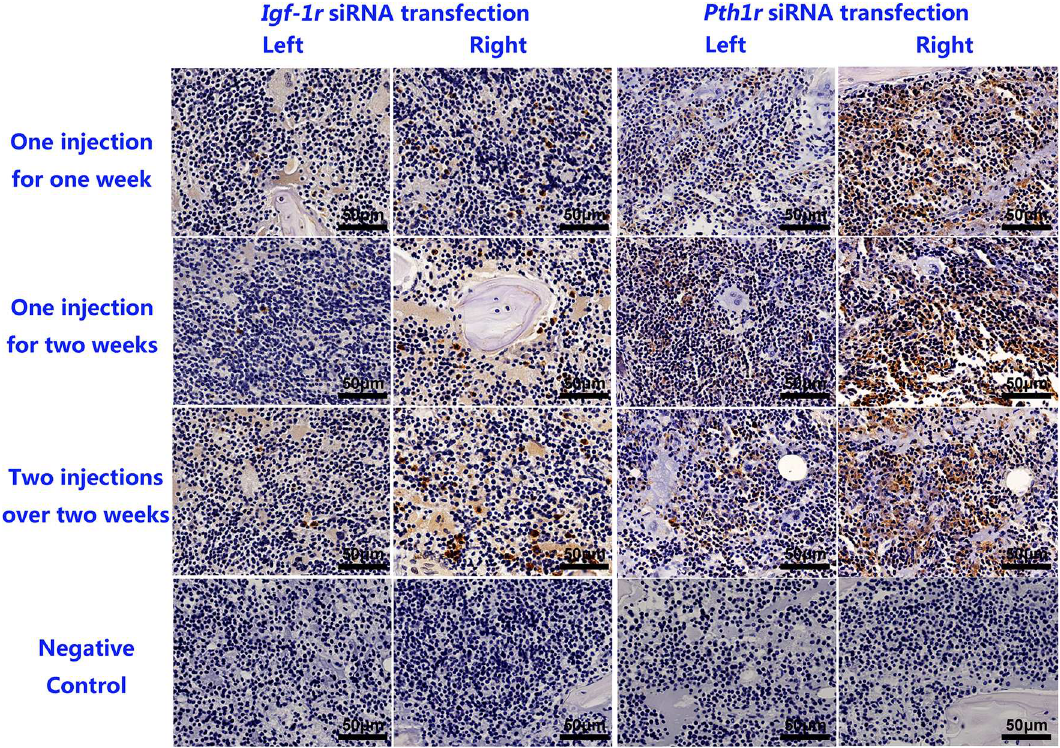
Fig 3. Immunohistochemical Staining for IGF-1R and PTH1R. The first three rows are representative images of the bone marrow of left tibias treated with Igf-1r siRNA and IGF-1 or Pth1r siRNA and rhPTH (1–34). The bottom row representsthe isotype control for the anti-IGF-1R and anti-PTH1R antibodies. Scale bar = 50 μ m.